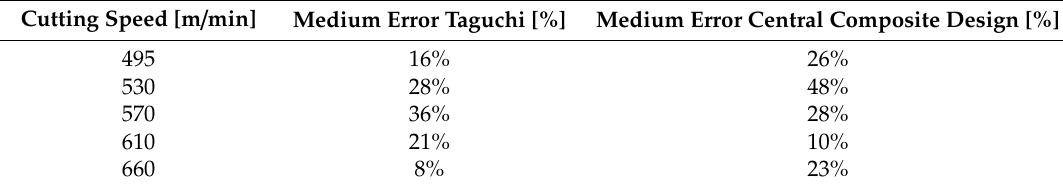
Table 11. Average errors of the R a measurements according to the cutting speed